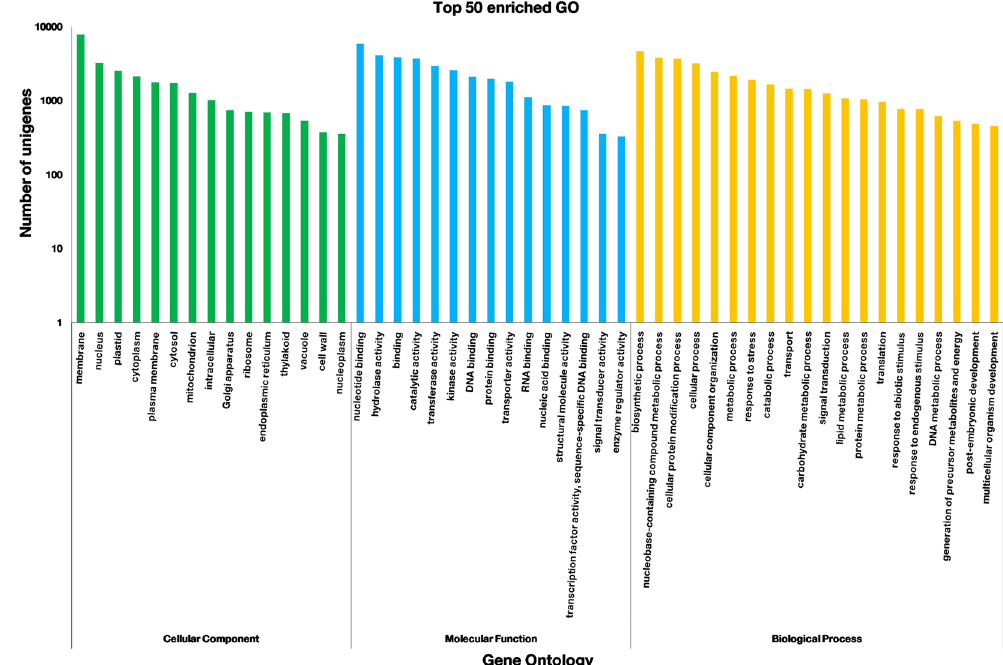
Figure 3. GO classification of Solanum trilobatum unigenes. The Histogram shows the results of unigene classification under three major categories of GO